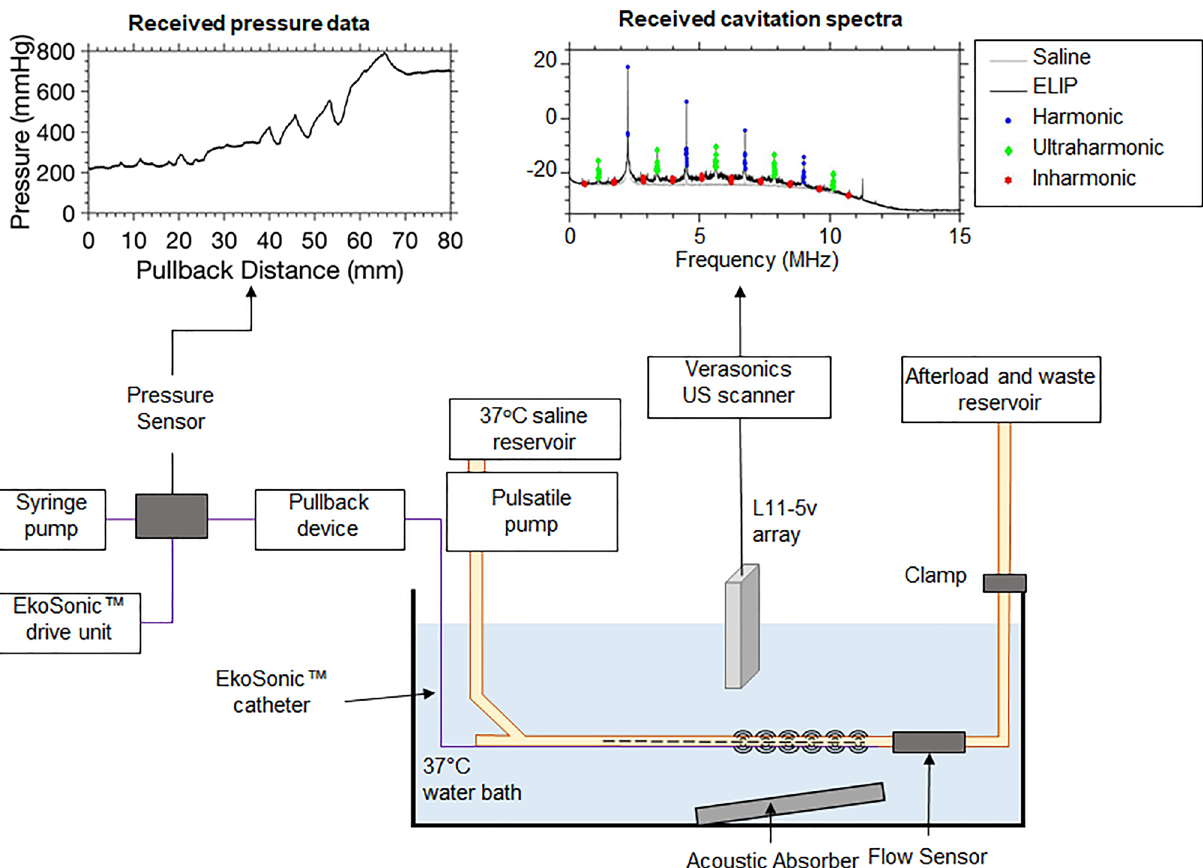
Figure 9. Schematic of flow phantom setup for passive cavitation imaging. Saline at 37 °C was pumped from the reservoir, over the catheter, to the afterload, and to the waste reservoir. During each experimental run, the catheter was pulled back within the tubing so that the L11-5v array scanned across the active transducer pairs (modified from Lafond et al. 22